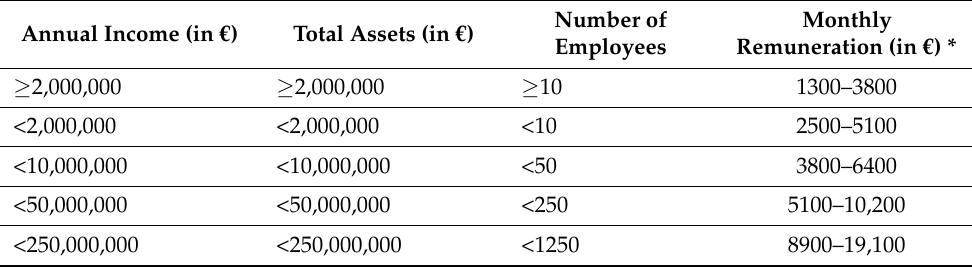
Table 1. Fixed remuneration of management board